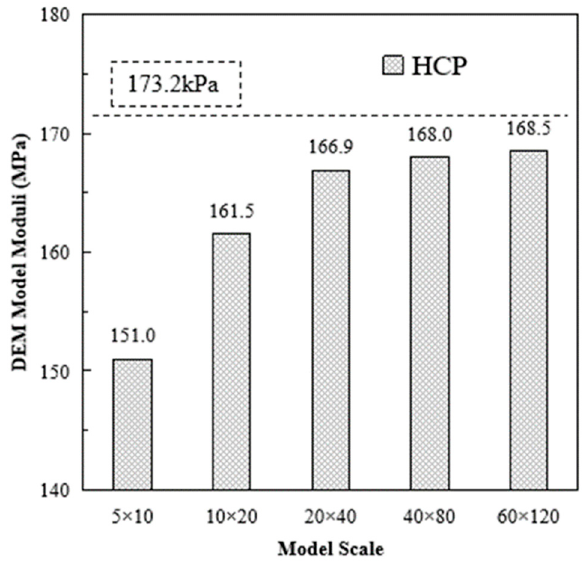
Figure 8. Obtained Moduli of HCP Stiffness validation Models with Bonding.